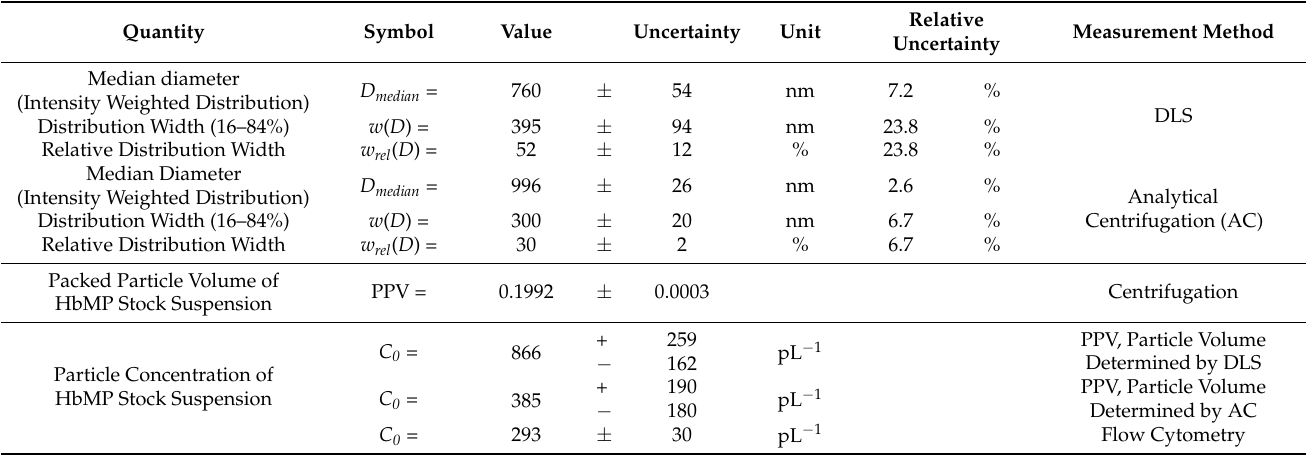
Figure 4. ( a ) NEXAFS fluorescence spectra of an oxygenated HbMP suspension (dot-dashed red trace) and metHbMP (dashed brown graph). For comparison, the absorbance of reference spectra for Fe(II) and Fe(III) [18] are included as blue and green lines, respectively. ( b ) Analysis of the oxygenated HbMPs (dot-dashed red curve) spectra as superposition of HbMPs containing 35% metHb and 65% oxyHb. Table 1. Summary of results for the characterization of the HbMP suspension. Besides the (sphere equivalent) median particle diameter and the particle distribution width, the packed particle volume, the concentration and densities relevant for our analysis are